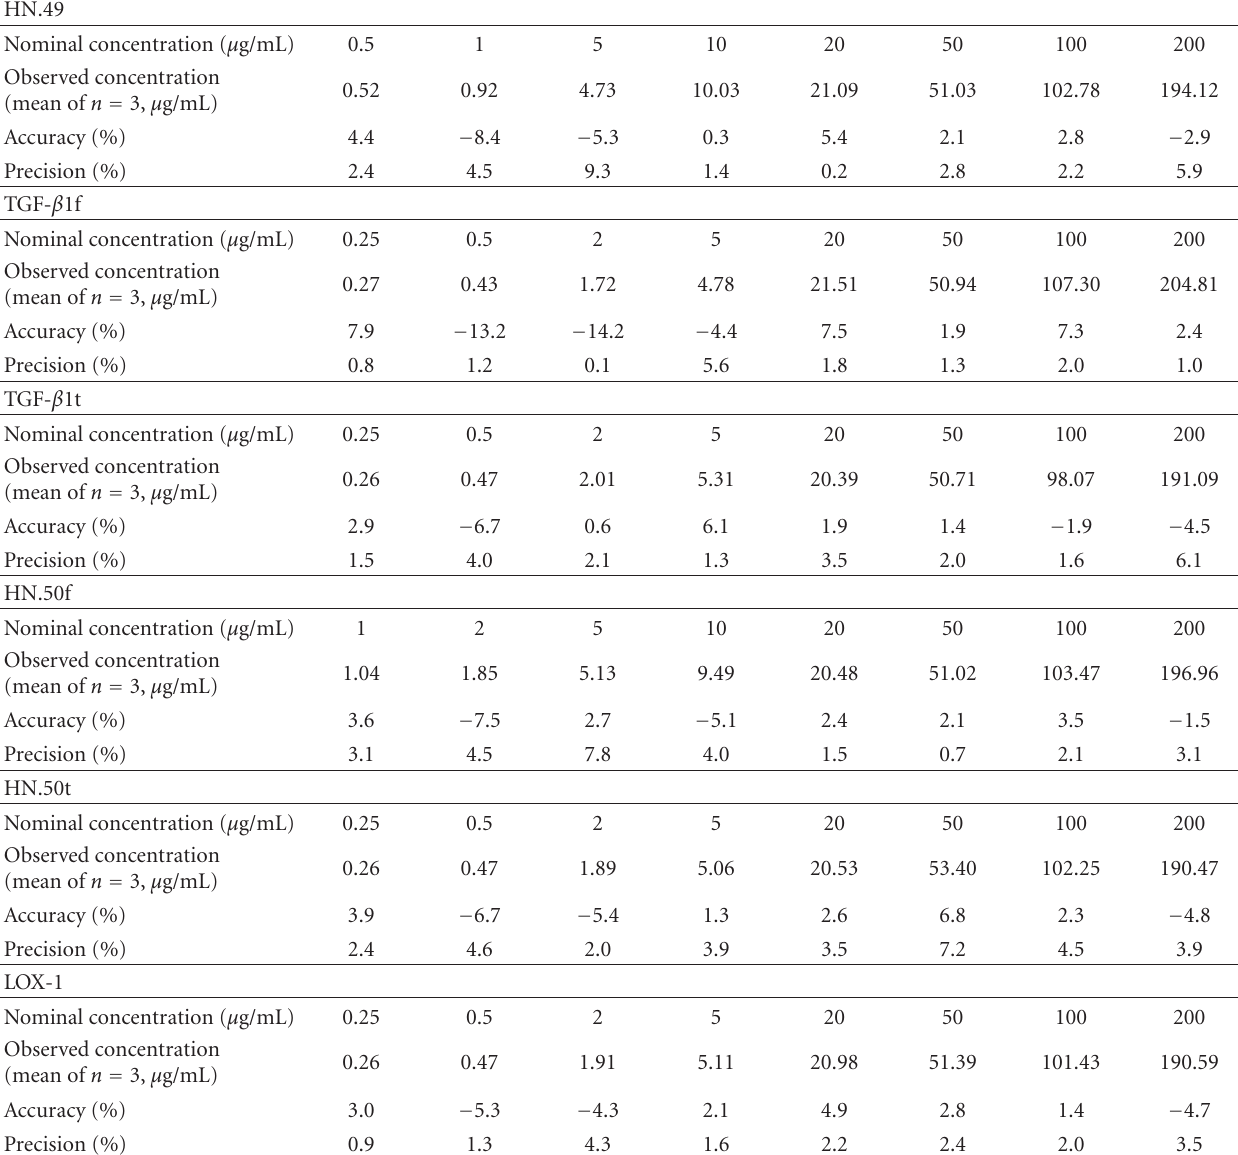
Table 1: Back calculated concentrations of the calibration curves of PI polyamides in rat